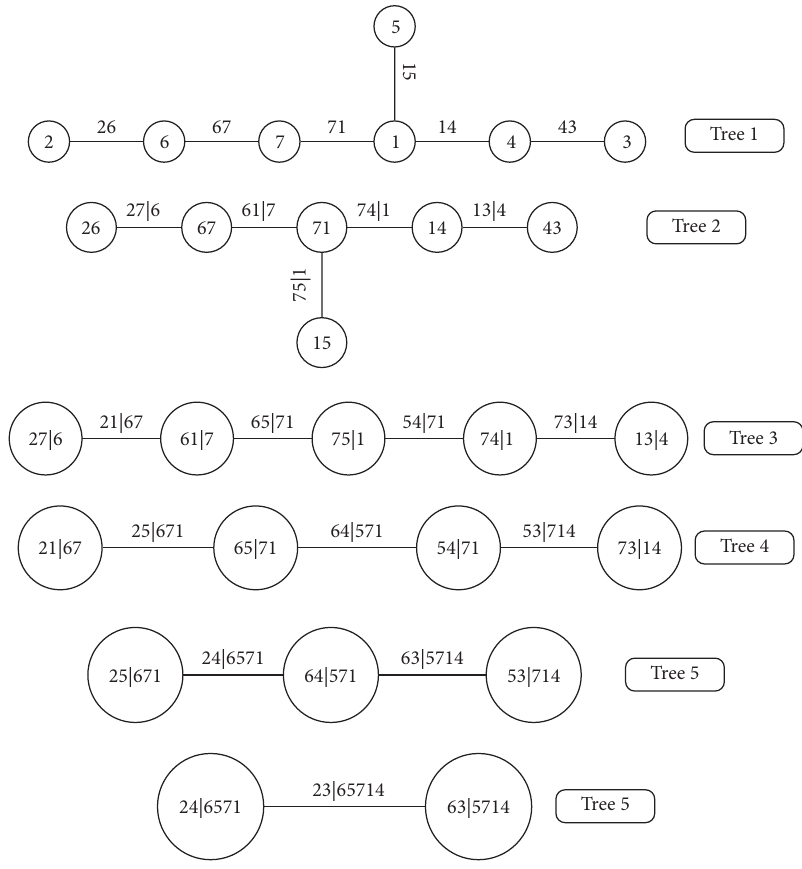
Figure 1: 7-dimensional R -vine copula mixture model, 6 trees, 21 edges, and 63